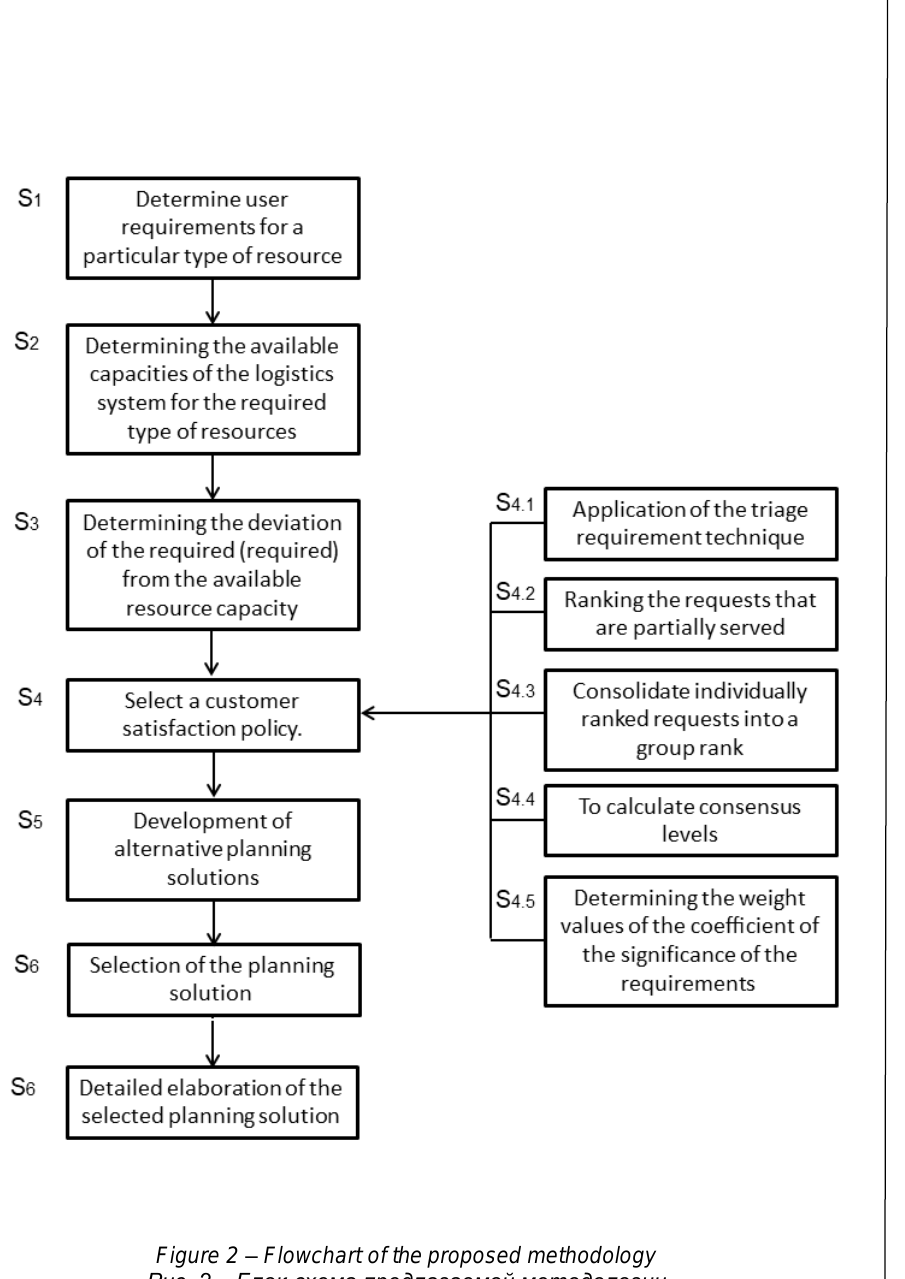
Figure 2 – Flowchart of the proposed methodology Рис. 2 – Блок-схема предлагаемой методологии Слика 2 – Дијаграм тока предложене